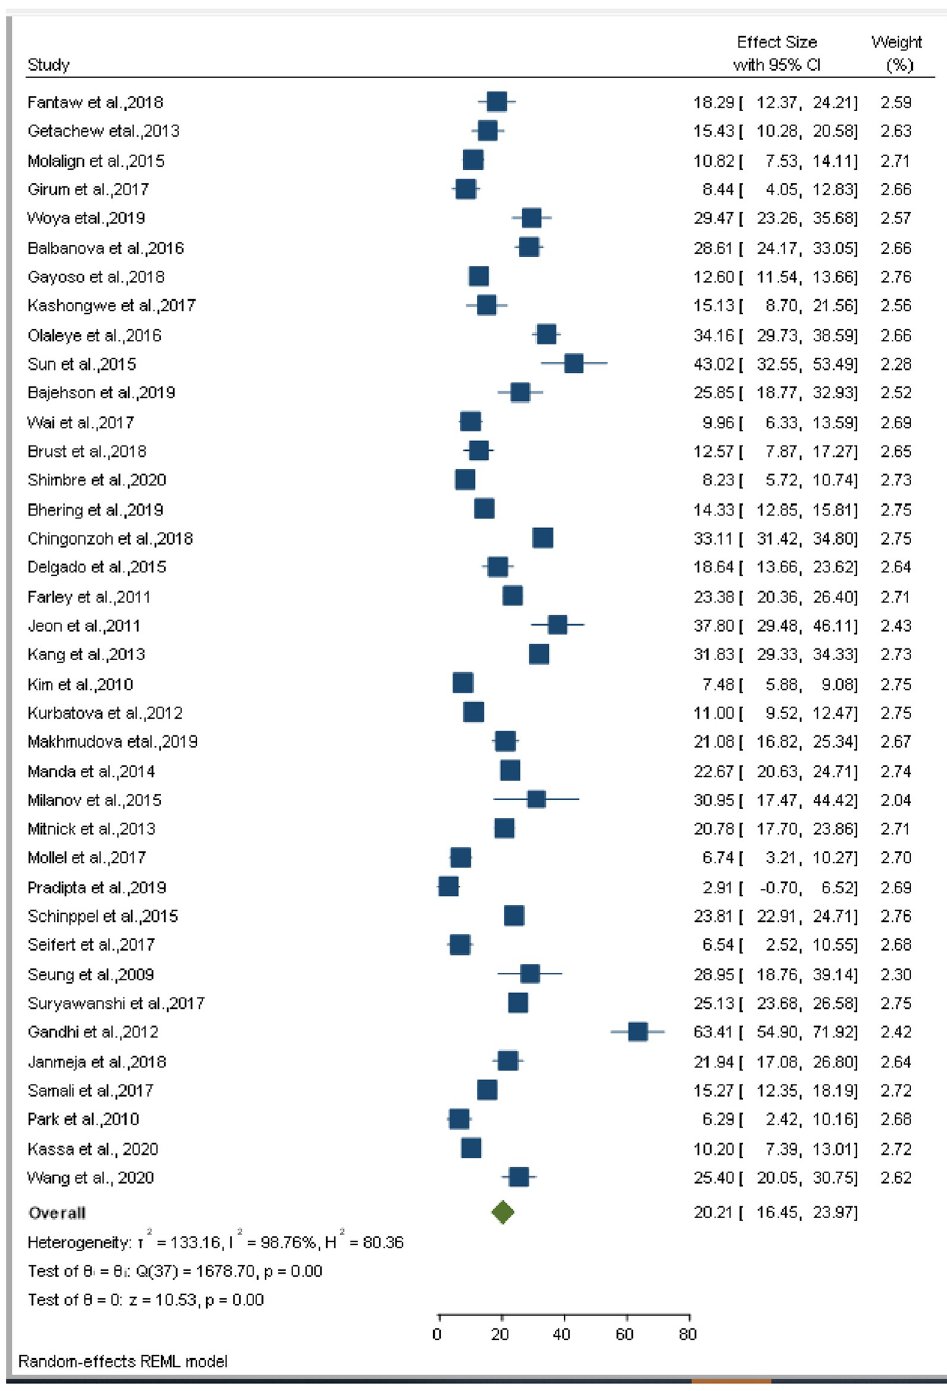
Fig 6. Forest plot for pooled incidence of mortality in patients with multi drug-resistant tuberculosis.